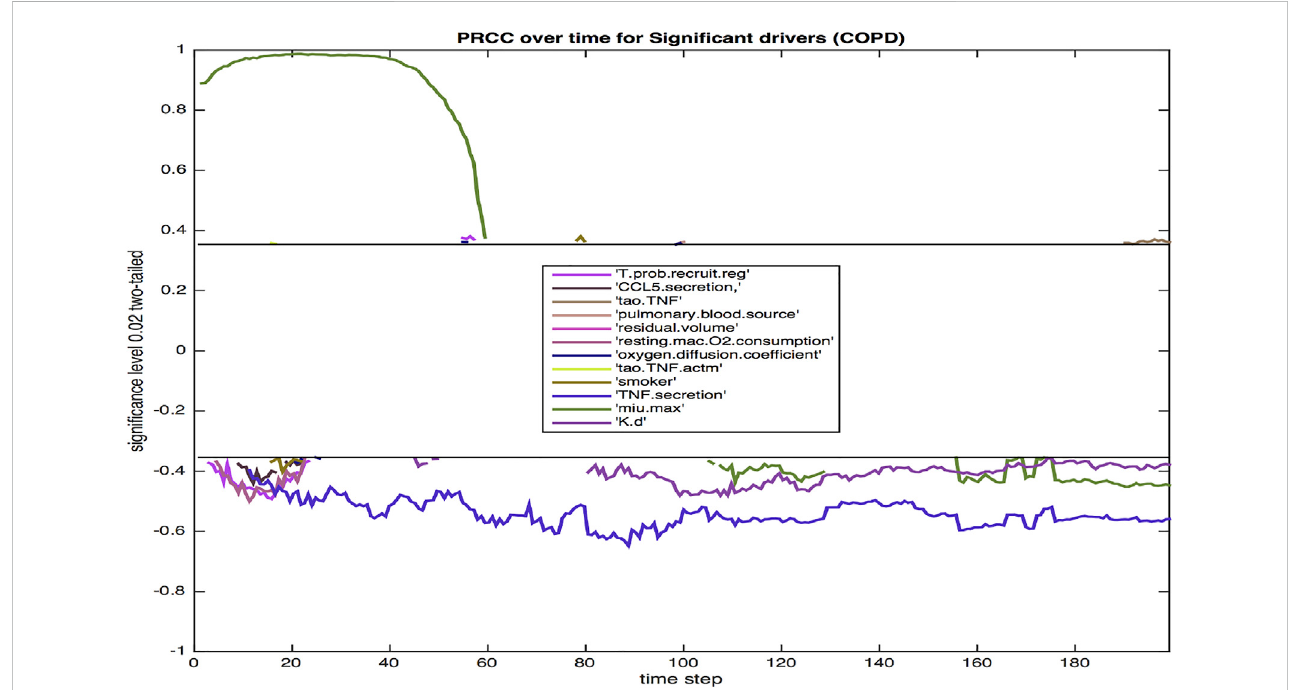
FIGURE 7 The PRCC for the model with COPD at p = 0.02 over the 200 day infection cycle. Parameters are de fi ned in the Results section.